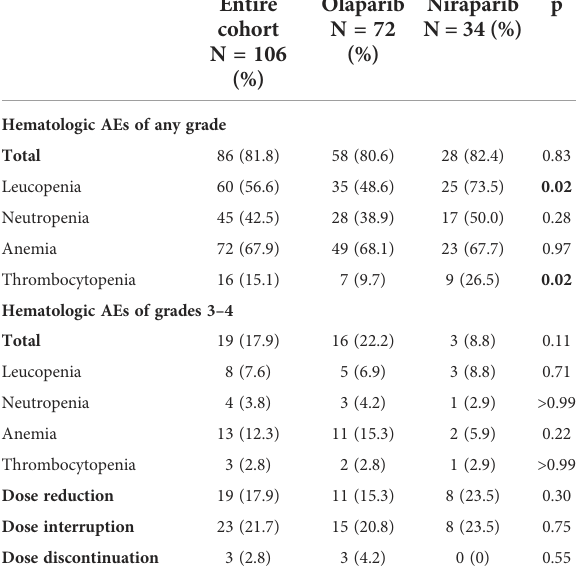
TABLE 4 Hematologic AEs and dose